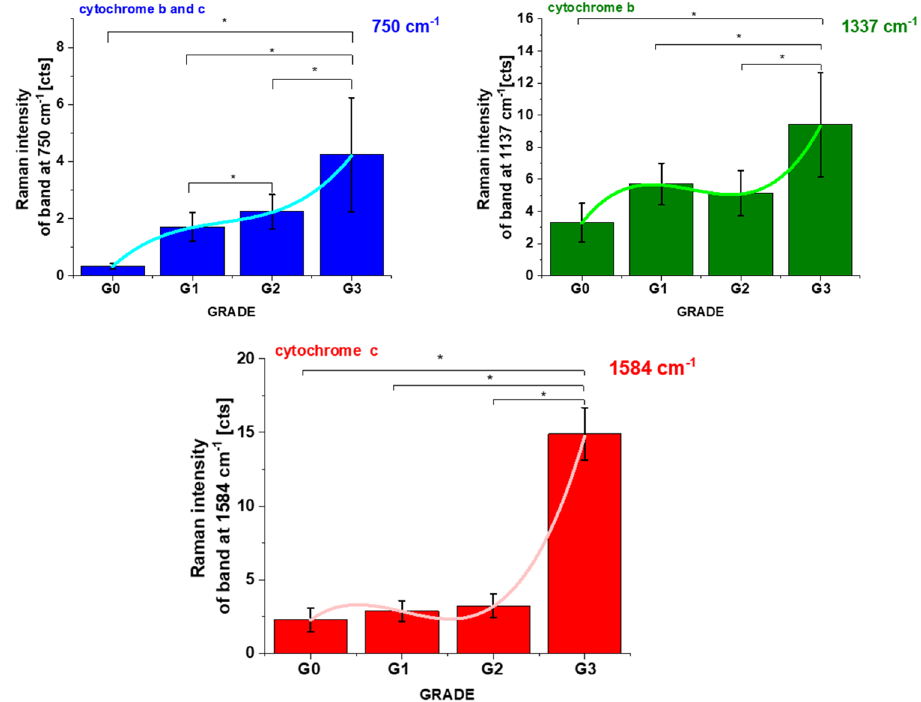
Figure 3. The Raman intensities I 750 , I 1337, I 1584 of Cyt c and Cyt b bands in human breast tissues as a function of breast cancer grade malignancy G0-G3 at excitation 532 nm, average ± SD, the statistically significant result have been marked with asterisk. The one-way ANOVA using the Tukey test was used to calculate the value significance, asterisk * denotes that the differences are statistically significant, p -values ≤ 0.05 were accepted as statistically